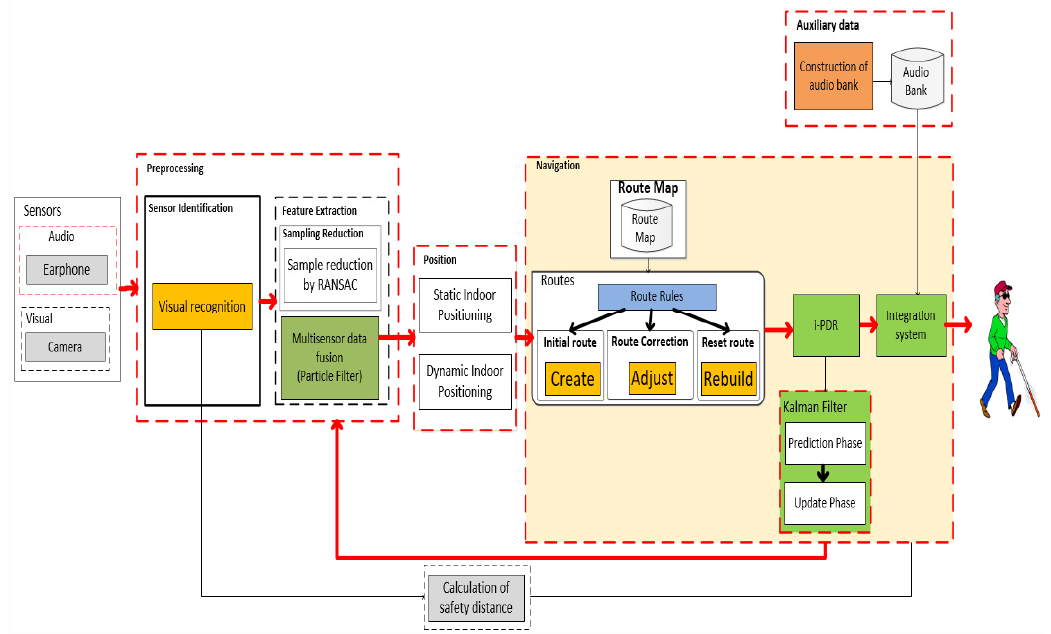
Figure 10. Indoor navigation system architecture.